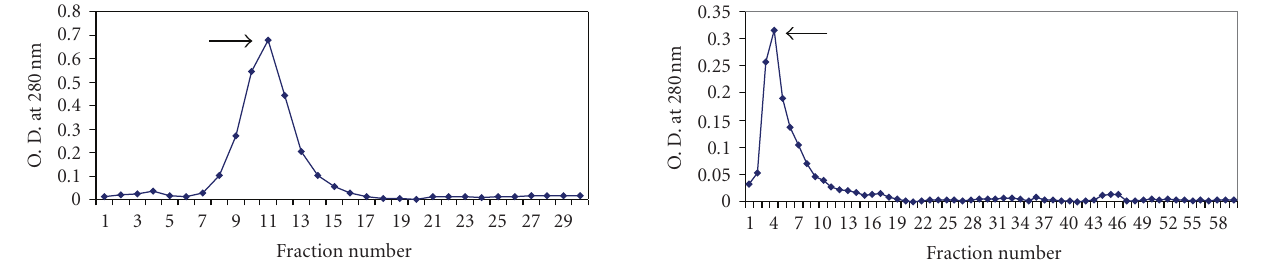
Figure 2: Elution pattern of sperm immobilization factor from E. coli on DEAE cellulose column.